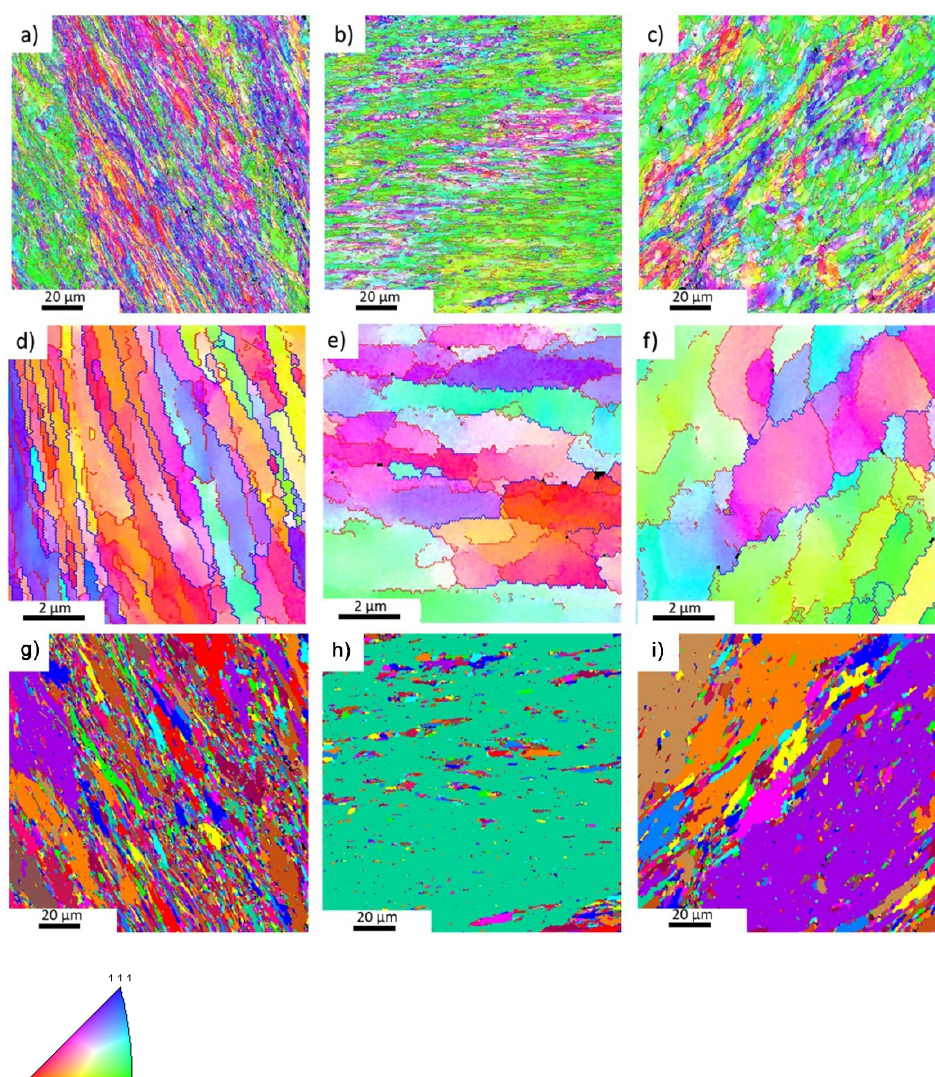
direction. Figure 5d–f colorized by unique color (considering a minimum misorientation of 5 ◦ ) show that large grains observed in the original bar are split into a submicrometer grains or subgrains after processing with rotating mandrel. The proportion of HAGBs was 80–90% in all maps, i.e., most objects observed in Figure 5d–f are recrystallized grains. To obtain information on the local strain distribution inside grains of the final tubes, KAM maps were evaluated from EBSD measurements. KAM describes the average mis- orientation of a selected point relatively to all neighboring points. The distance between Figure 3. The grain structure ( a ) in the center of the initial bar (LM), and that of samples processed neighboring points was selected 50 nm in our measurement. The KAM threshold value with ( b ) stationary, and ( c ) rotating mandrel on the PD plane, SEM-BSE. was chosen to be 5 ◦ to exclude large misorientations due to subgrain boundaries or LAGBs The orientation image maps (OIMs) taken from 3 perpendicular directions, ND, RD, and with higher misorientations (5 to 15 ◦ ). The correlation between the local lattice distortion PD, for the sample processed with stationary mandrel are presented in Figure 4. and the color in KAM maps is given in Figure 6.